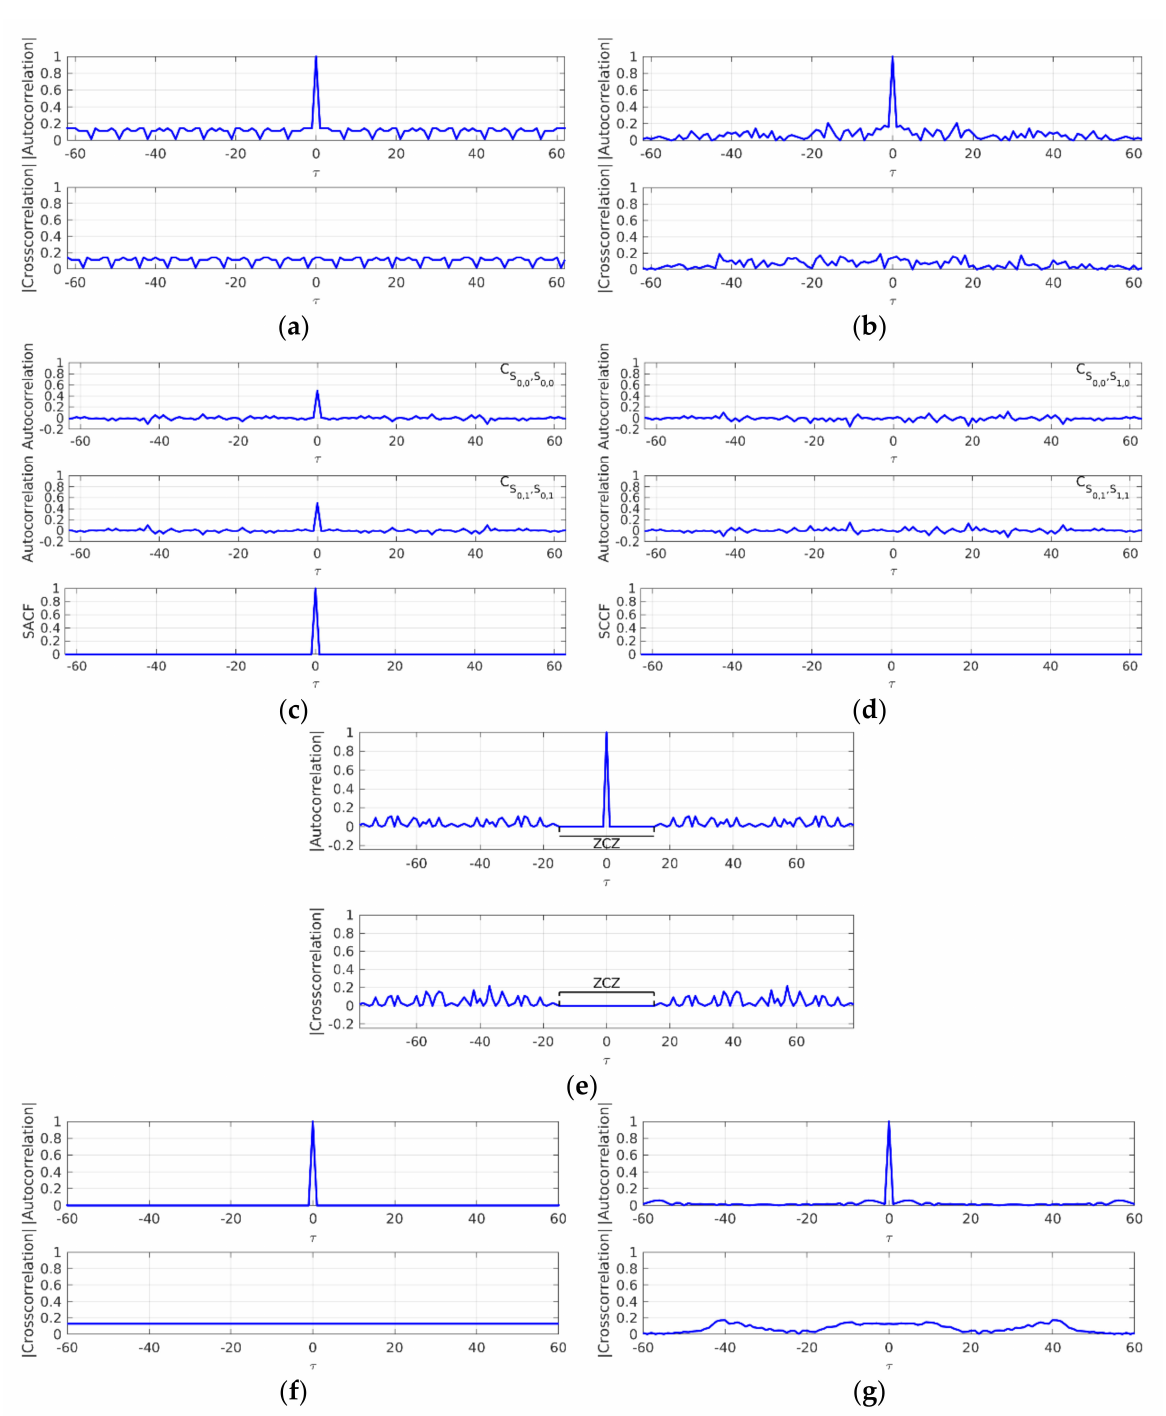
Figure 3. Correlation functions for those sequences considered in the CODEUS platform: ( a ) nor- malized periodic and ( b ) aperiodic correlation functions of Kasami sequences with length L Kas = 63; ( c ) SACF and ( d ) SCCF for CSS with M CSS = 2 and L CSS = 64; ( e ) normalized aperiodic correla- tion function of LS sequences with length L LS = 79 and Zero Correlation Zone around the origin ZCZ = 15; ( f ) normalized periodic and ( g ) aperiodic correlation function for Zadoff-Chu sequences with L ZC =